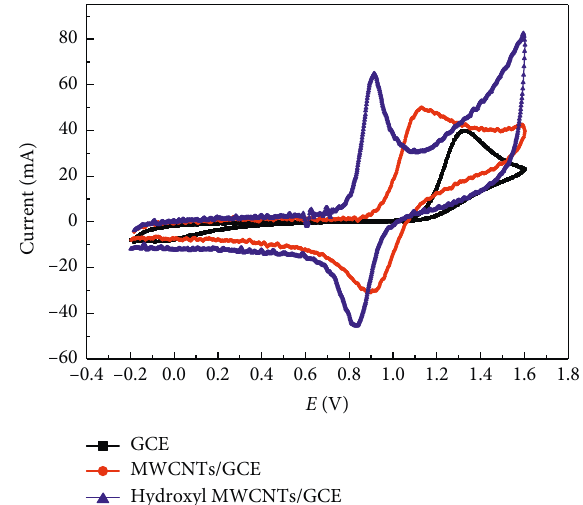
Figure 5: CV curves of different electrodes at a constant scan rate of 20